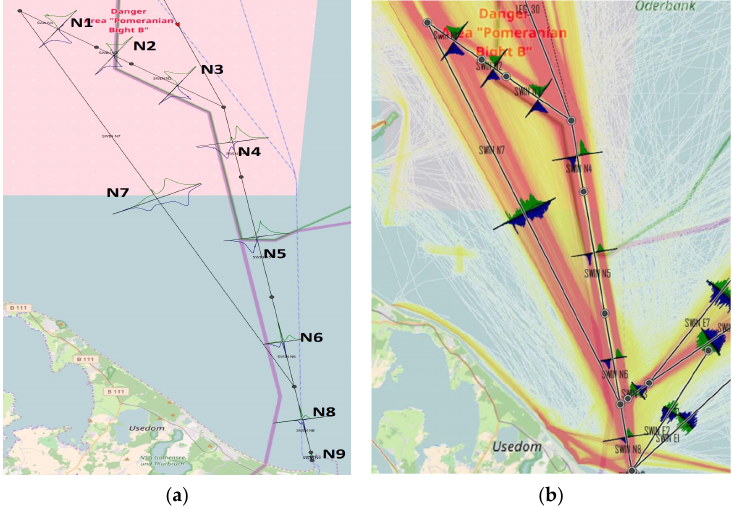
Figure 2. Pomeranian Bayresearch area: ( a ) Established sections; ( b ) density plot.